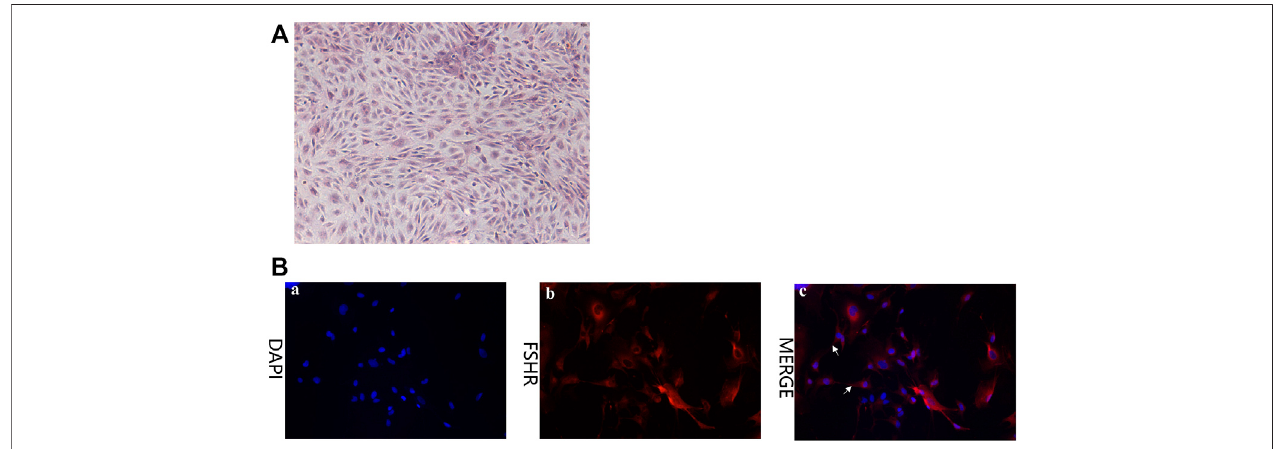
FIGURE 4 | Characterization of granulosa cells (GCS) isolate from ovaries of healthy female rabbits (5 months of age). (A) H&E staining (40×). (B) Expression of follicle-stimulating hormone receptor (FSHR) in GCS isolated from ovaries of rabbits as detected via immuno fl uorescence staining (red = FSHR; blue = nuclei) (200×). Pseudopodia between cells are indicated with white